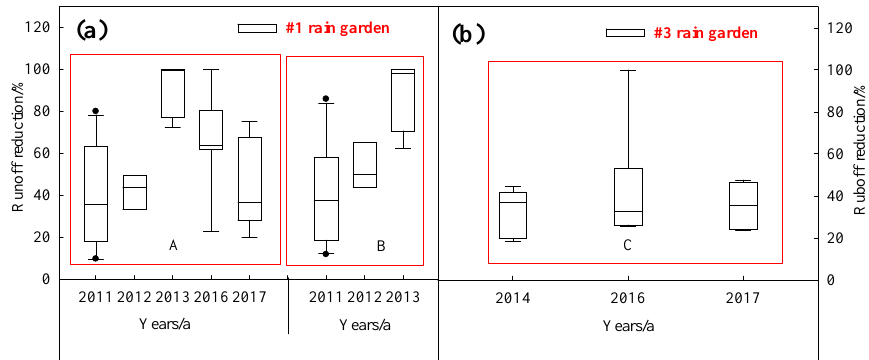
Figure 5. Runoff reduction effect of rain gardens No. 1 and 3. Note: ( a ) The annual average runoff reduction rate in rain garden No. 1A and B from 2011 to 2017; ( b ) The annual average runoff reduction rate in rain garden No. 3C from 2014 to 2017.